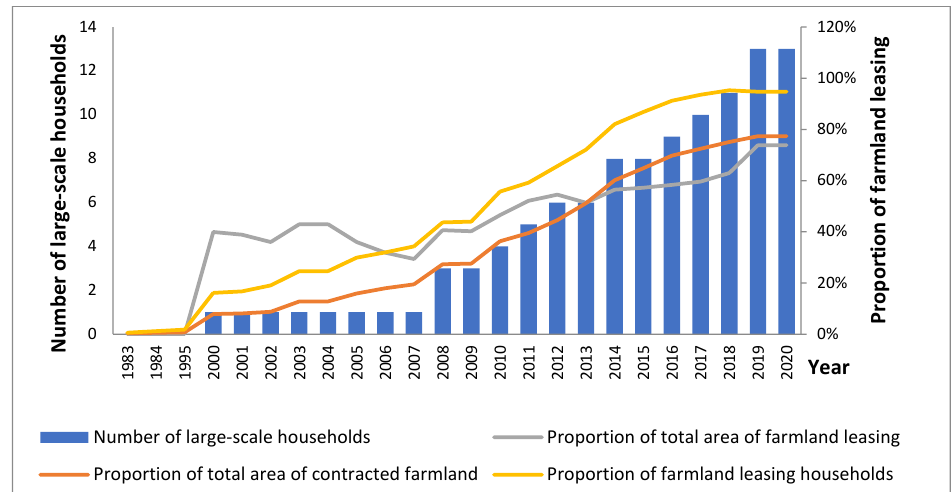
Figure 3. General process of farmland leasing in Huang village.